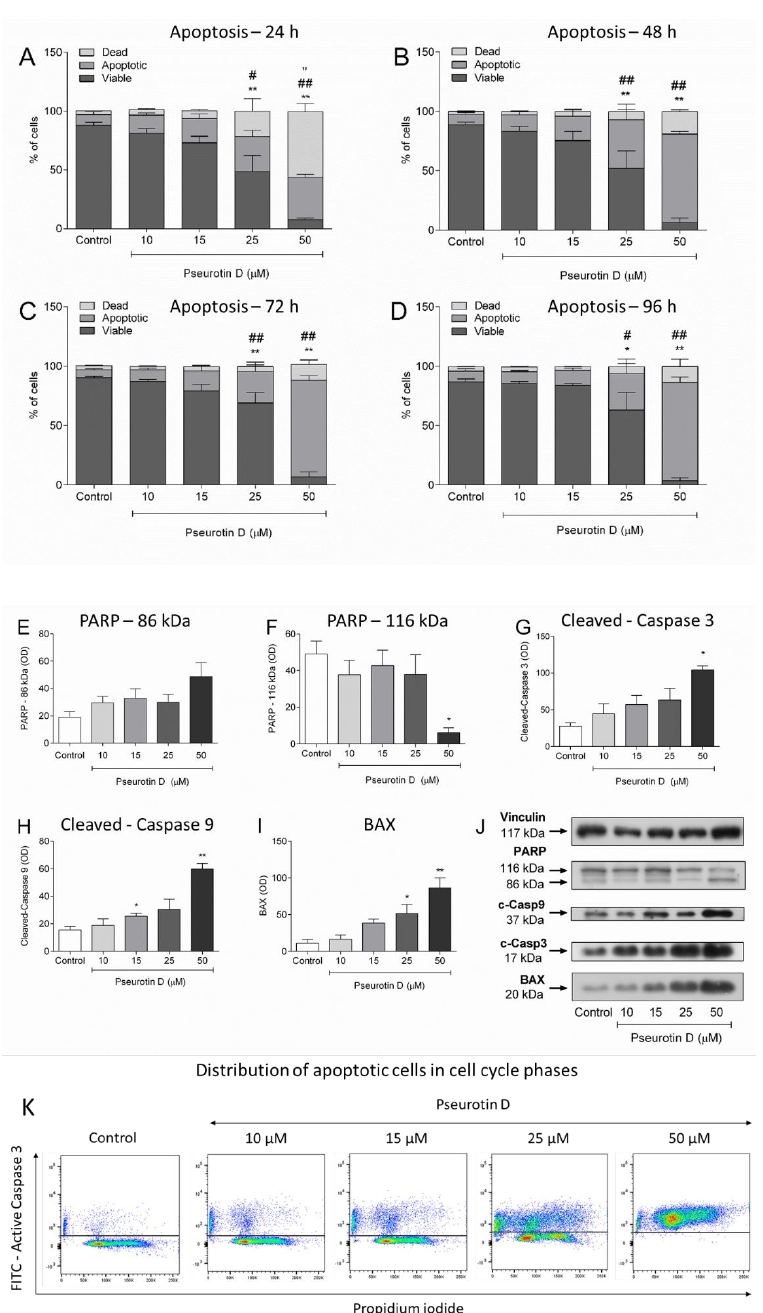
Figure 2. The effect of pseurotin D (1 – 50 µM) on the induction of MEC-1. The distribution of viable, apoptotic, and dead cells was determined on the basis of AnexinV/PI staining after 24, 48, 72, and 96 h ( A – D ). The level of cleaved caspase-3, cleaved caspase-9, PARP, BAX, and vinculin, as an equal loading control, were determined by Western blot analysis after 24 h ( E – J ). The distribution of apoptotic cells in cell cycle phases was determined by using antibody against active caspase-3 conjugated by FITC and PI staining ( K ). Data were expressed as the mean ± SEM ( n = 3) and analyzed by ANOVA combined with Dunnett’s test (** p < 0.01 and * p < 0.05). In ( A – D ) * represents the statistical analysis of the viable cells, # represents the statistical analysis of the apoptotic cells, and “ represents the statistical analysis of the dead